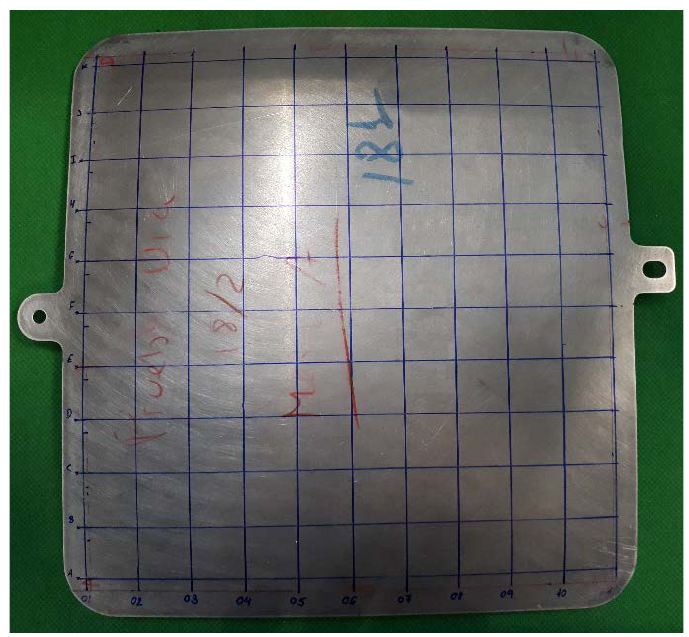
Figure 4. Real hydroformed Piece 1, with a marked surface grid, required to measure the height of different nodes.